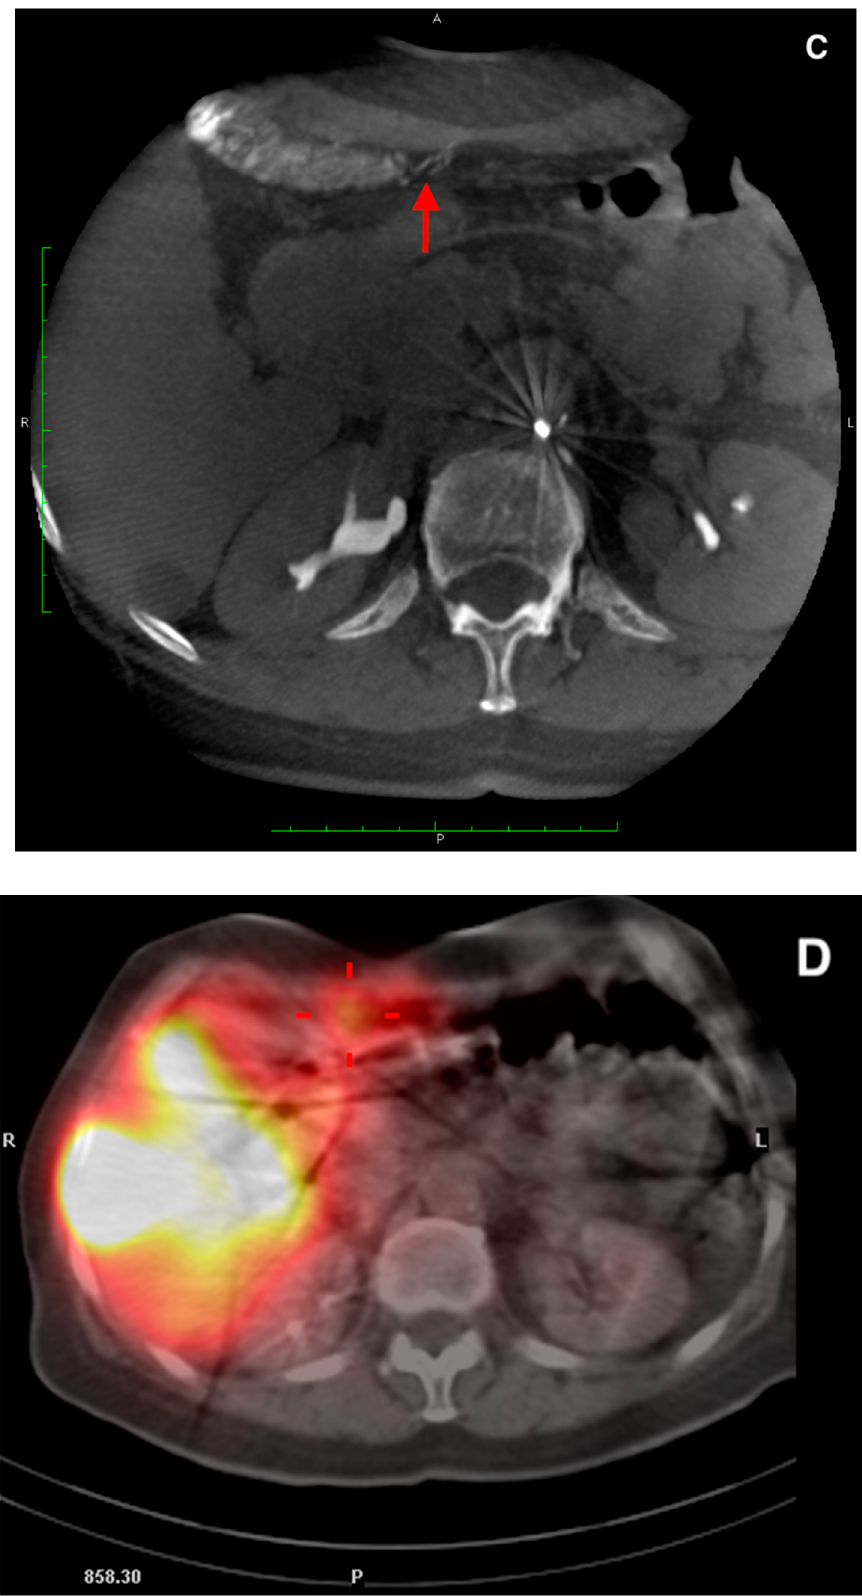
Figure 6. ( A ) Angiogram of the left hepatic artery showing falciform artery travelling medially beyond the margin of the liver. ( B ) Its presence was confirmed on Dyna-CT and showed contrast enhancement of the abdominal wall (arrows) ( C ), and on SPECT/CT after 99m Tc-MAA injection ( D ) ( crosshairs ).